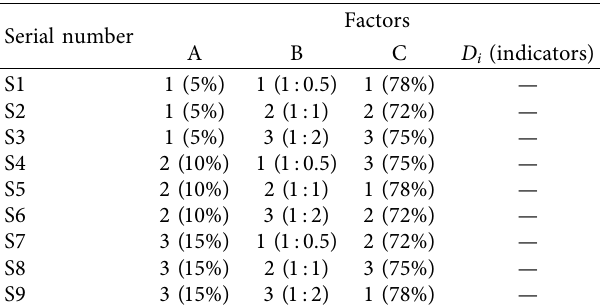
Table 2: L 3 ) orthogonal test design table of paste filling 9 (3